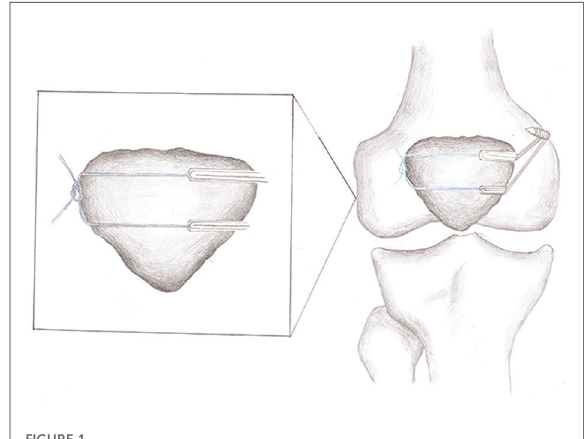
FIGURE 1 Schematic diagram for MPFL reconstruction of patella double semi- tunnel.